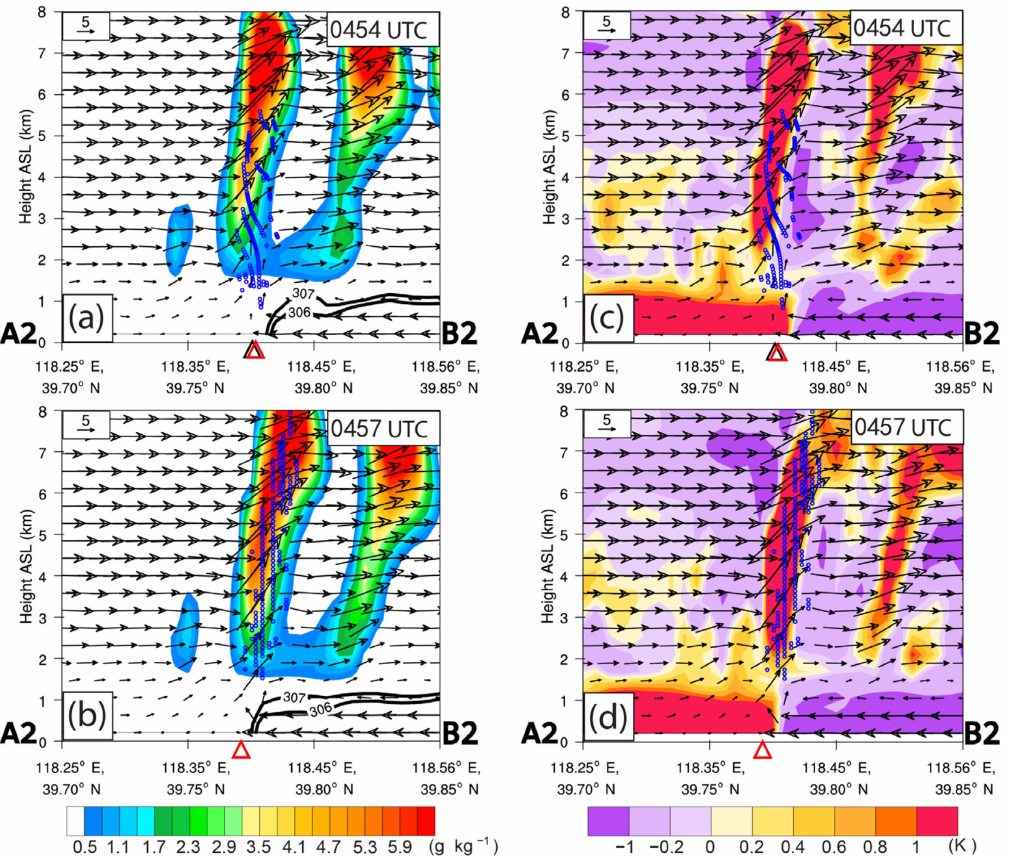
Figure 14. ( a , b ) Vertical cross section of the hydrometeors (including rain, cloud, ice, graupel, and snow) (shading, units: g kg − 1 ) and wind fields (vector arrows) along the line segment A2B2 in Figure 10b on 31 July 2010. ( c , d ) are the same as ( a , b ) but for the potential temperature anomaly (shading, units: K). The specific time is shown in the upper right corner of each panel. The black and red triangle symbols indicate the locations of the leading edges of the SBF and GF,